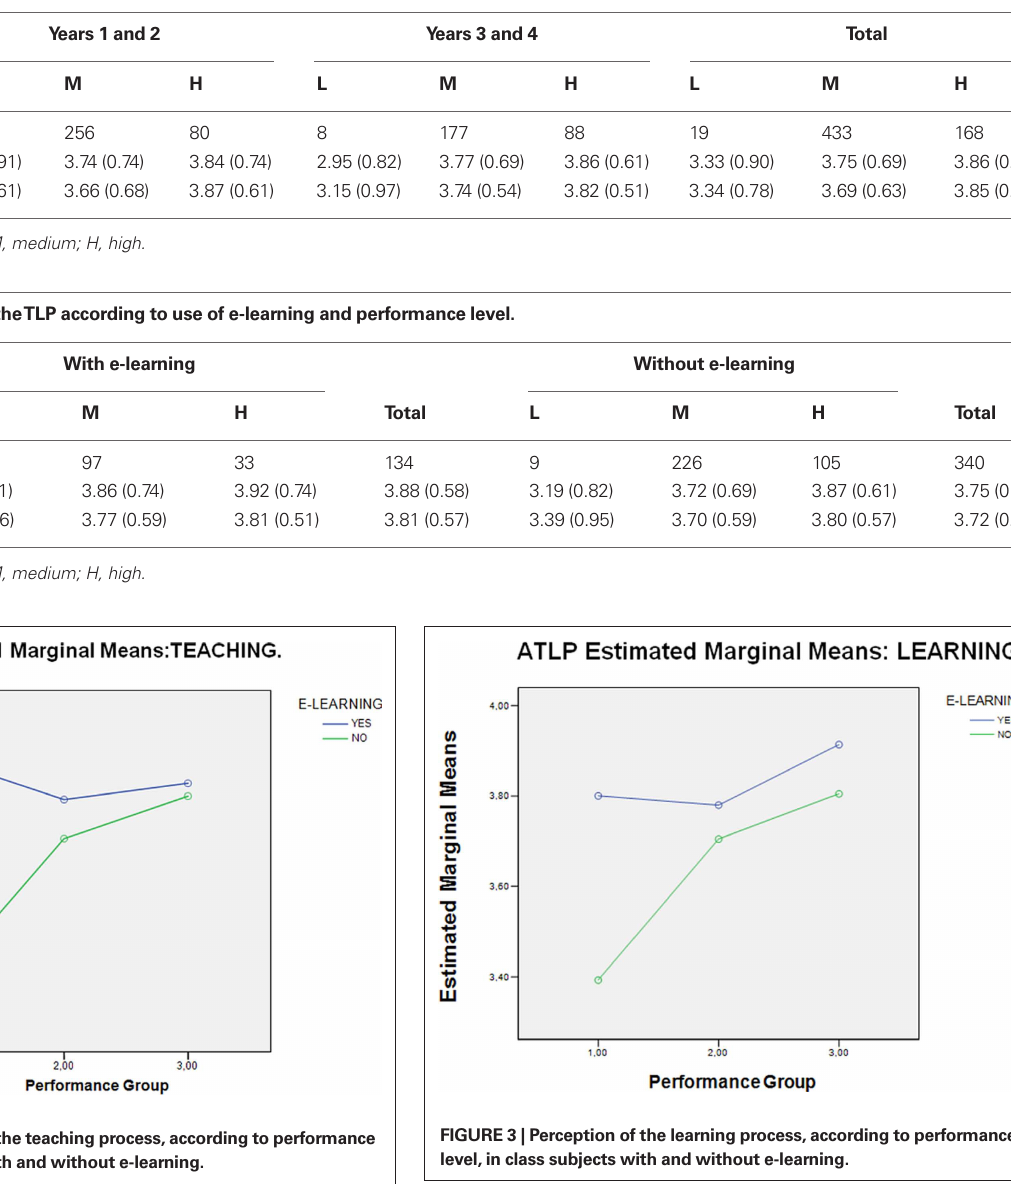
Table 1 | Mean values for the TLP according to year in school and performance level.